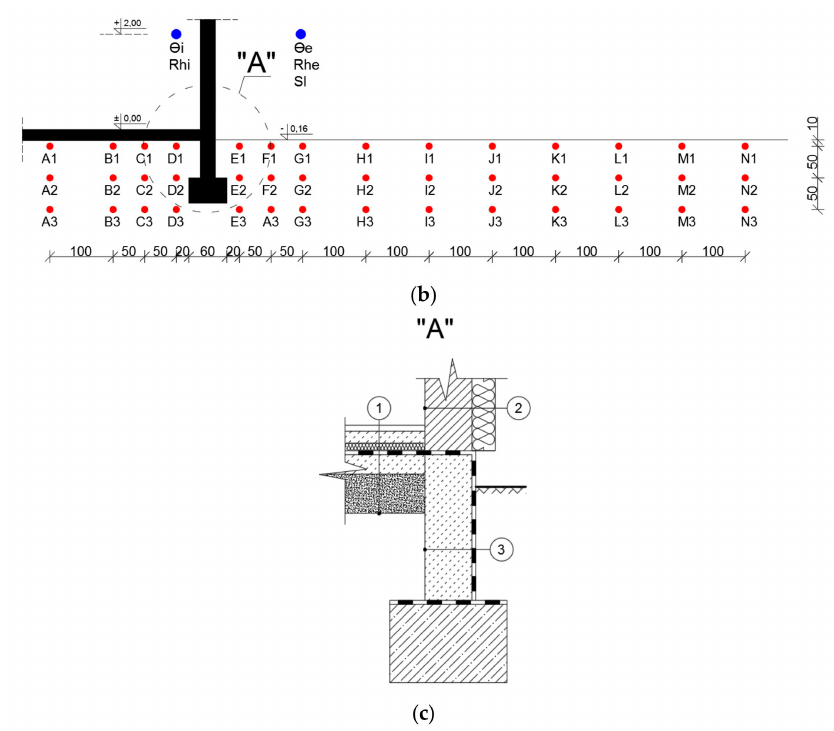
Figure1. PlacementofA1–N3soiltemperaturesensorsandindoor( Θ i )andoutdoor( Θ e )airtemperature sensors. ( a ) horizontal projection, ( b ) cross section I-I, and ( c ) details of foundation: 1—parquet floor 0.03 m, 2—concrete floor 0.06 m, olyethyl 0.04 m, concrete 0.10 m, sand 0.30 m; 2—breeze blocks 0.24